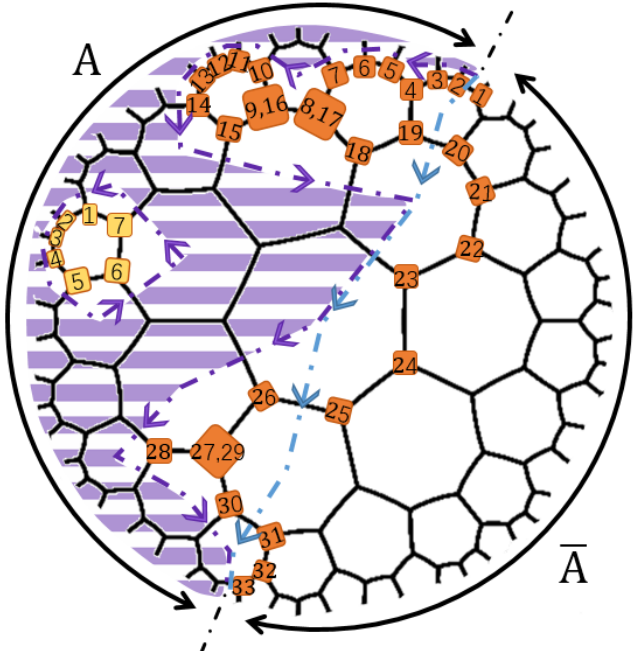
Figure 20 . A directed cut C during the course of the greedy algorithm starting from A is marked by purple dot-dashed lines, which consists of two connected components, an open curve and a closed curve. The open curve is denoted by [ N 1 ; N 2 ; (cid:1) (cid:1) (cid:1) ; N 33 ], with N 8 = N 17 ; N 9 = N 16 and N 27 = N 29 . The closed curve is denoted by ( N 0 ; N 0 ; (cid:1) (cid:1) (cid:1) ; N 0 ). The sub tensor networks (cid:8) absorbed by the 1 2 7 greedy algorithm is shaded with purple strips. A minimal secant geodesic G m is marked by blue dot-dashed